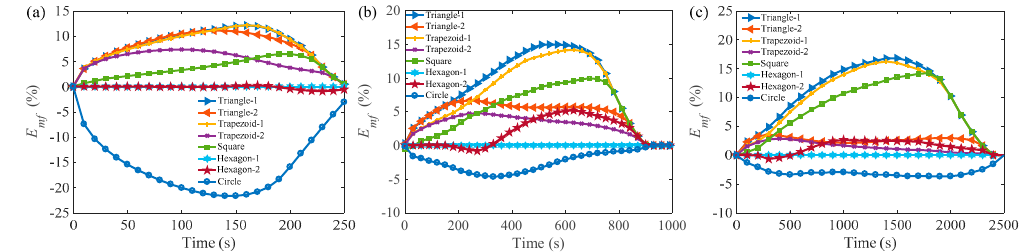
Figure 7. Instantaneous enhancement ratios of liquid fraction in the triangular, trapezoidal, square, hexagonal, and circular cells ( AR = 1.0) at ( a ) Ra = 3.095 × 10 5 ; ( b ) Ra = 4.83 × 10 6 ; ( c ) Ra = 3.87 × 10 7 .